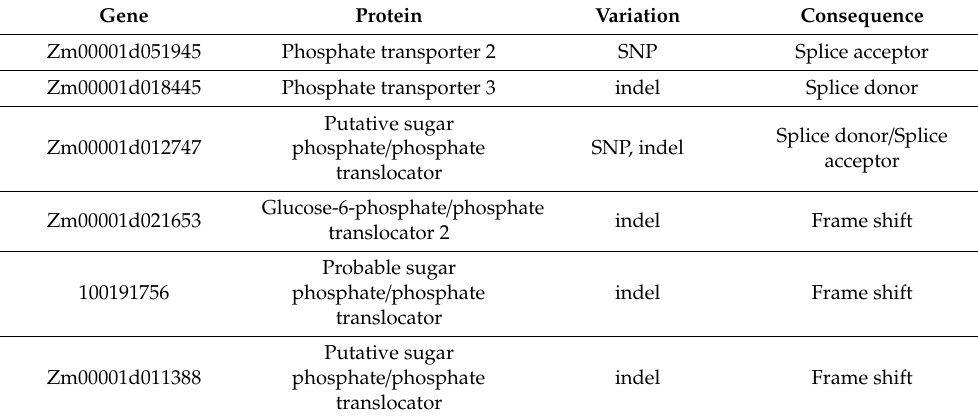
Table 4. Genes encoding phosphate transporters that were affected by identified variations.